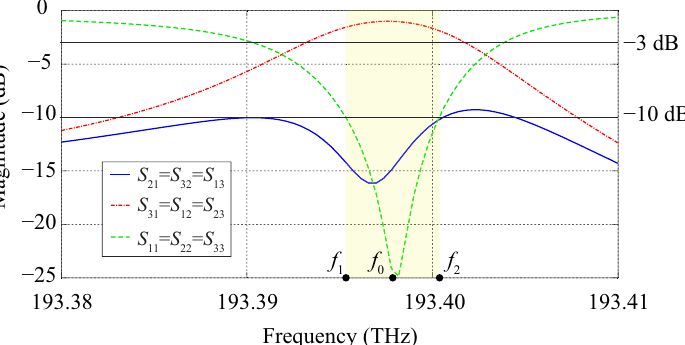
Figure 8. Frequency response obtained from 3D simulations performed with COMSOL Multiphysics.